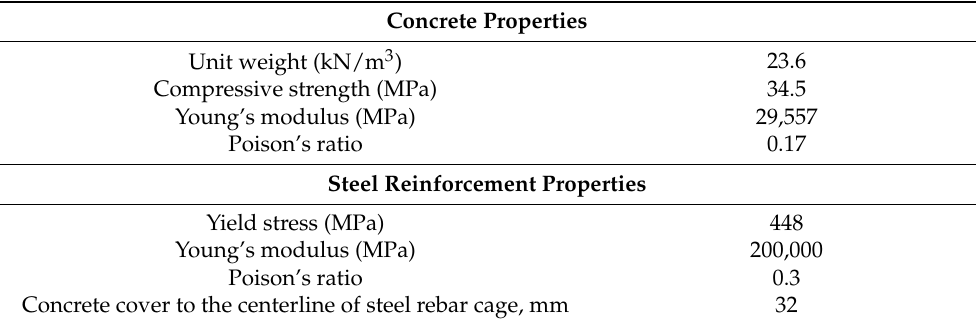
Table 4. Concrete and steel reinforcement